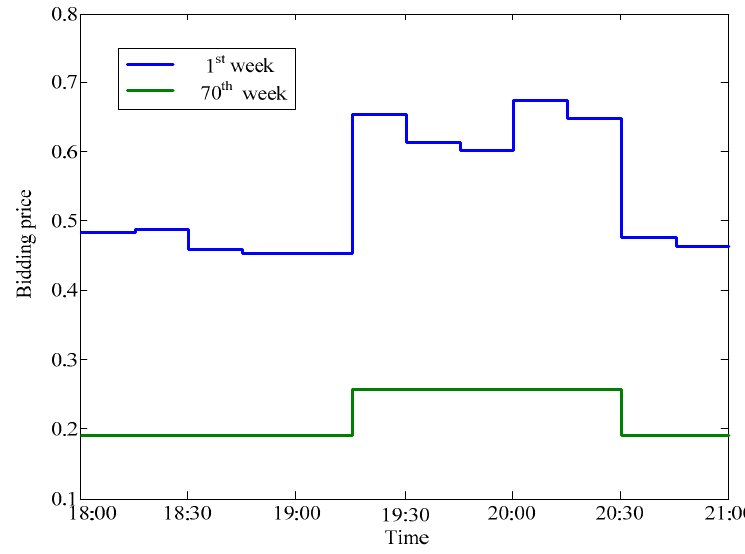
Figure 8. Bidding price in the 1st week and 70th week. 461